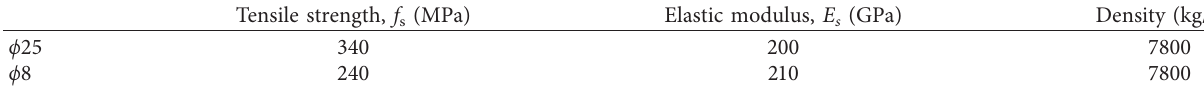
Table 2: Material properties of rebar.